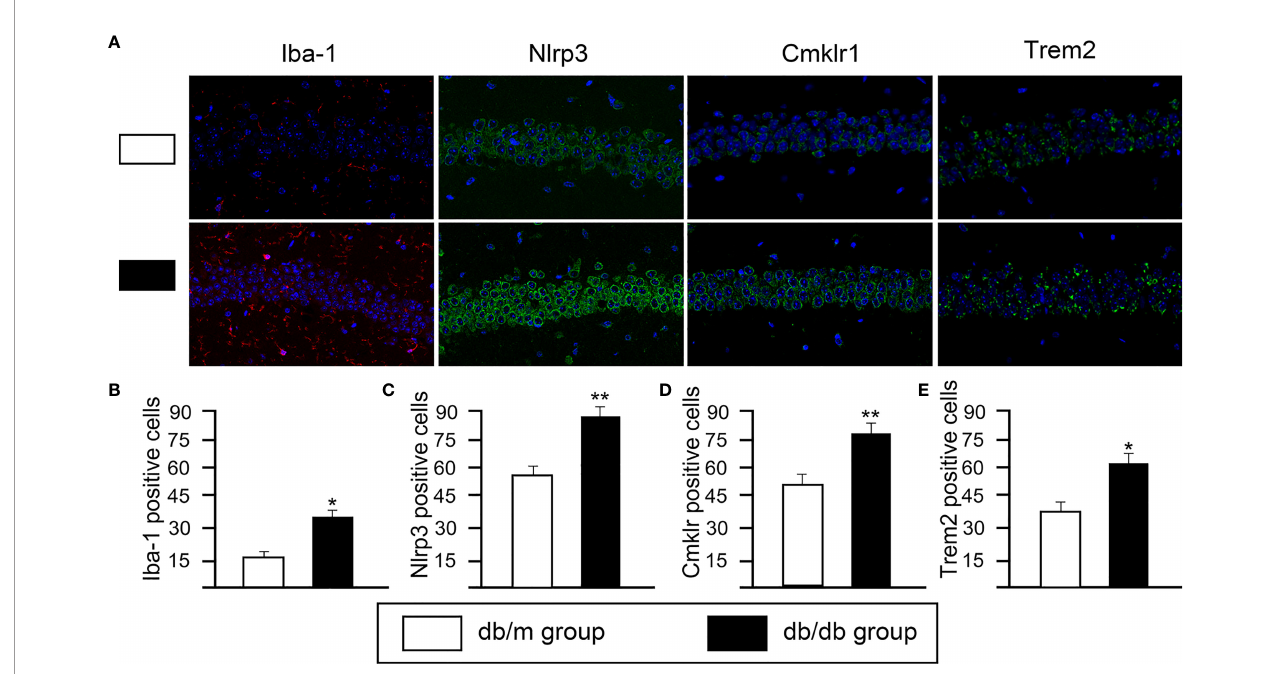
FIGURE 4 | The changes of microglial activation and neuroin fl ammation in hippocampal CA1 sections from from db/m and db/db group. (A) Representative immuno fl uorescence staining of Iba-1, Nlrp3, Cmklr1 and Trem2. Representative images of Iba-1 (red) staining and representative images of Nlrp3, Cmklr1, Trem2 (green) staining. Nuclei are stained with DAPI (blue). (scale bar = 50 mm). Quanti fi cation of Iba1- (B) , Nlrp3- (C) , Cmklr1- (D) , Trem2- (E) positive cells in the db/db mice hippocampus. All data are represented as means ± S.E.M for 8 mice in each group. *P < 0.05, **P < 0.01 vs. db/m